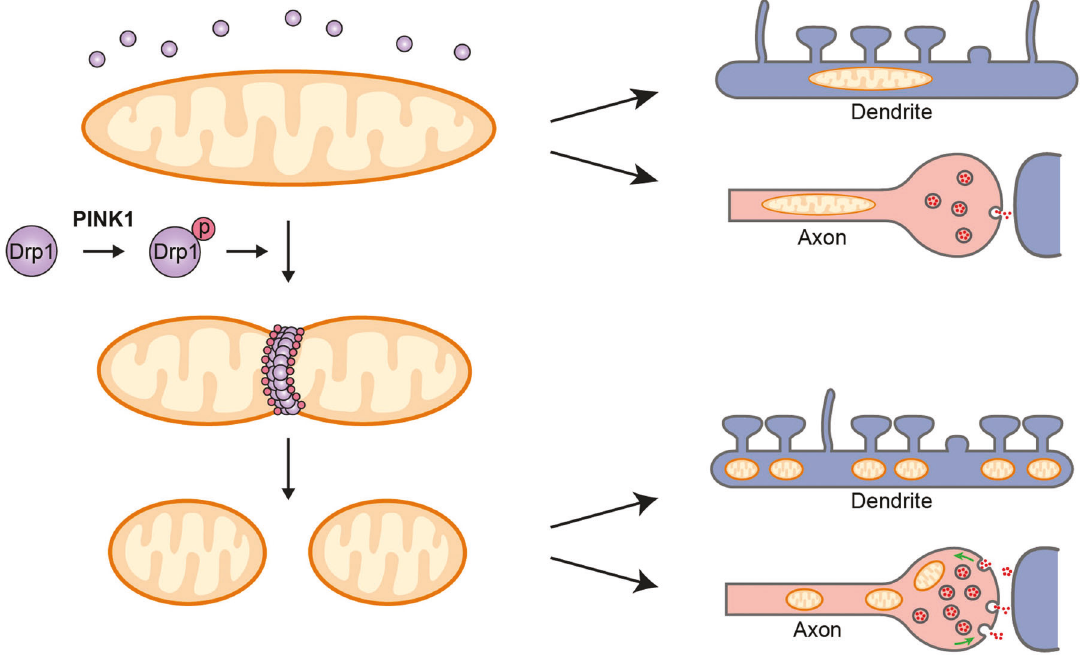
Fig. 8 Schematic illustration of PINK1-mediated Drp1 S616 phosphorylation to regulate synaptic transmission and plasticity via mitochondrial fi ssion. Fused mitochondria (left top panel) become fi ssed (left bottom panel) via a PINK1/phosphor-Drp1 S616 mediated mechanism (left middle panel). Fused mitochondria are dif fi cult to traf fi c to presynaptic terminals and dendrites (right upper panel) compared to fi ssed mitochondria (right lower